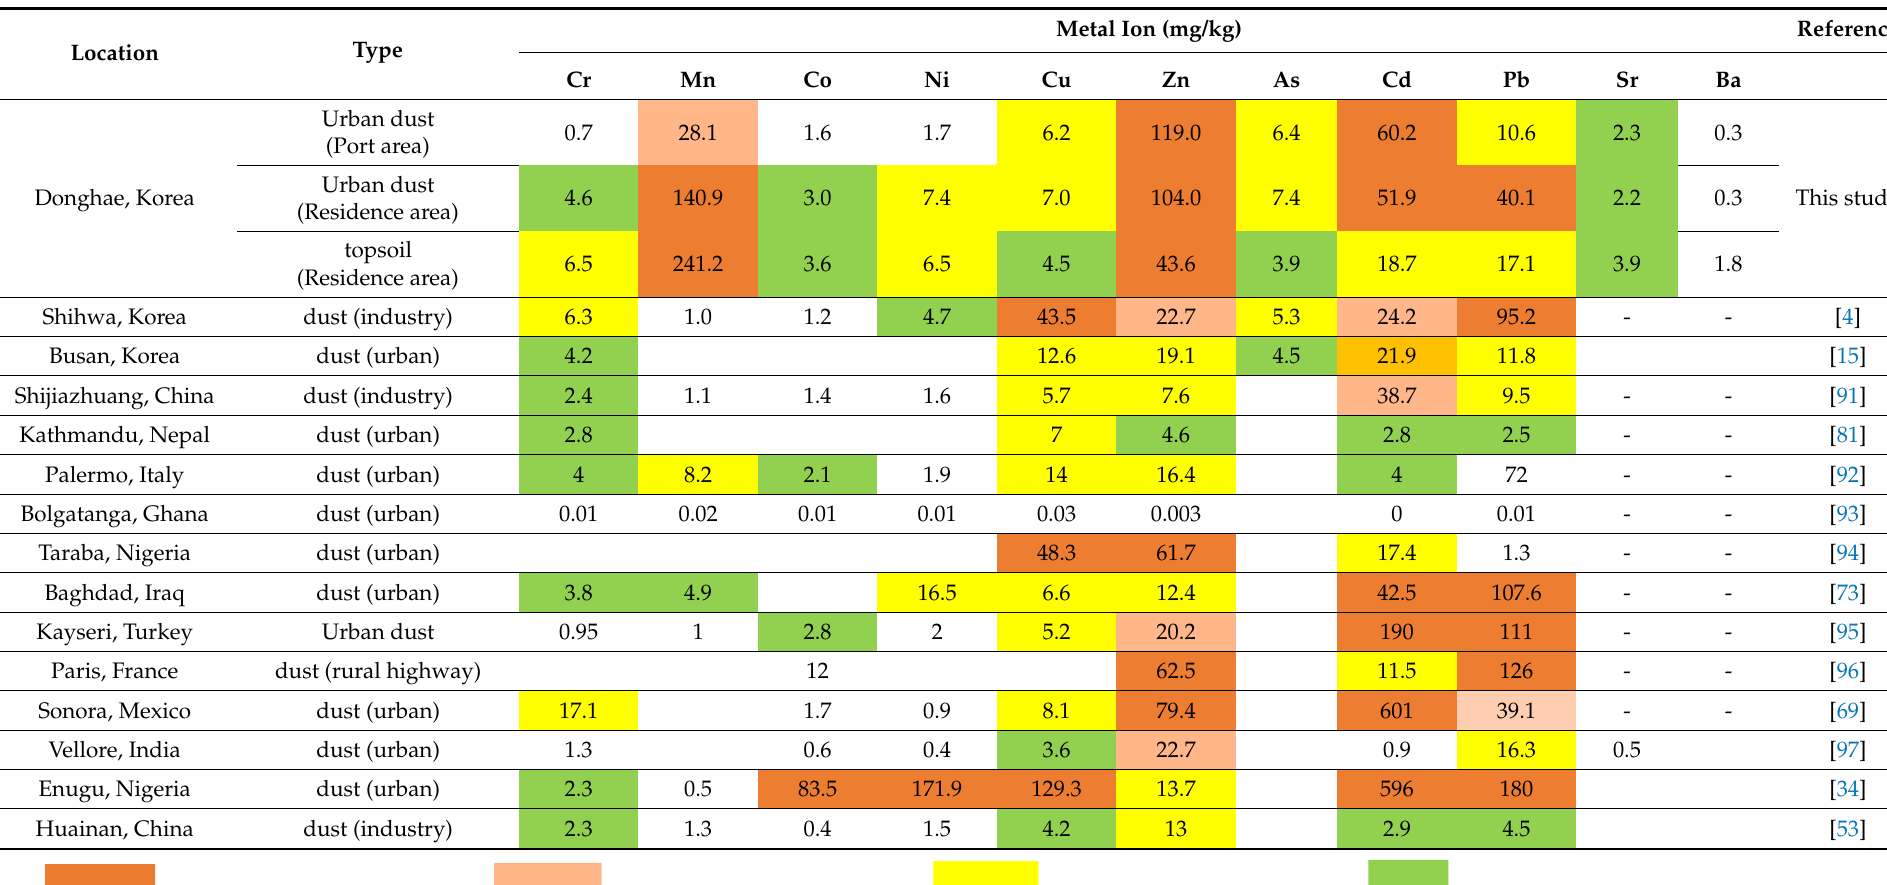
Table 3. Comparison of EF value in pollution source, control soil and urban dust sample of this study and other literature values. (EF < 2, minimal enrichment; 5 < EF > 2, moderate enrichment; 20 < EF > 5, significant enrichment; 40 < EF > 20, very high enrichment; and EF > 40, extremely high